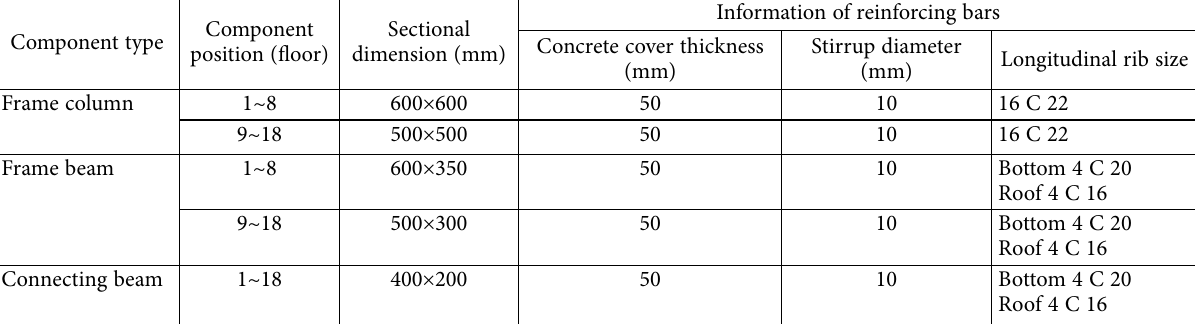
Table 1. Information of frame section